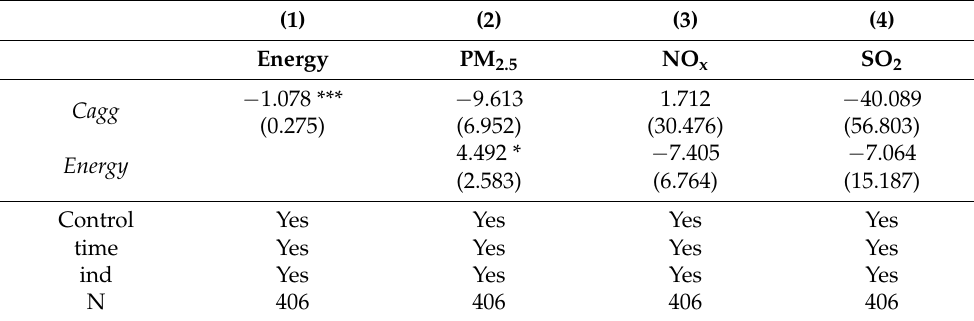
Table 14. Test of the mediating role of energy consumption structure in